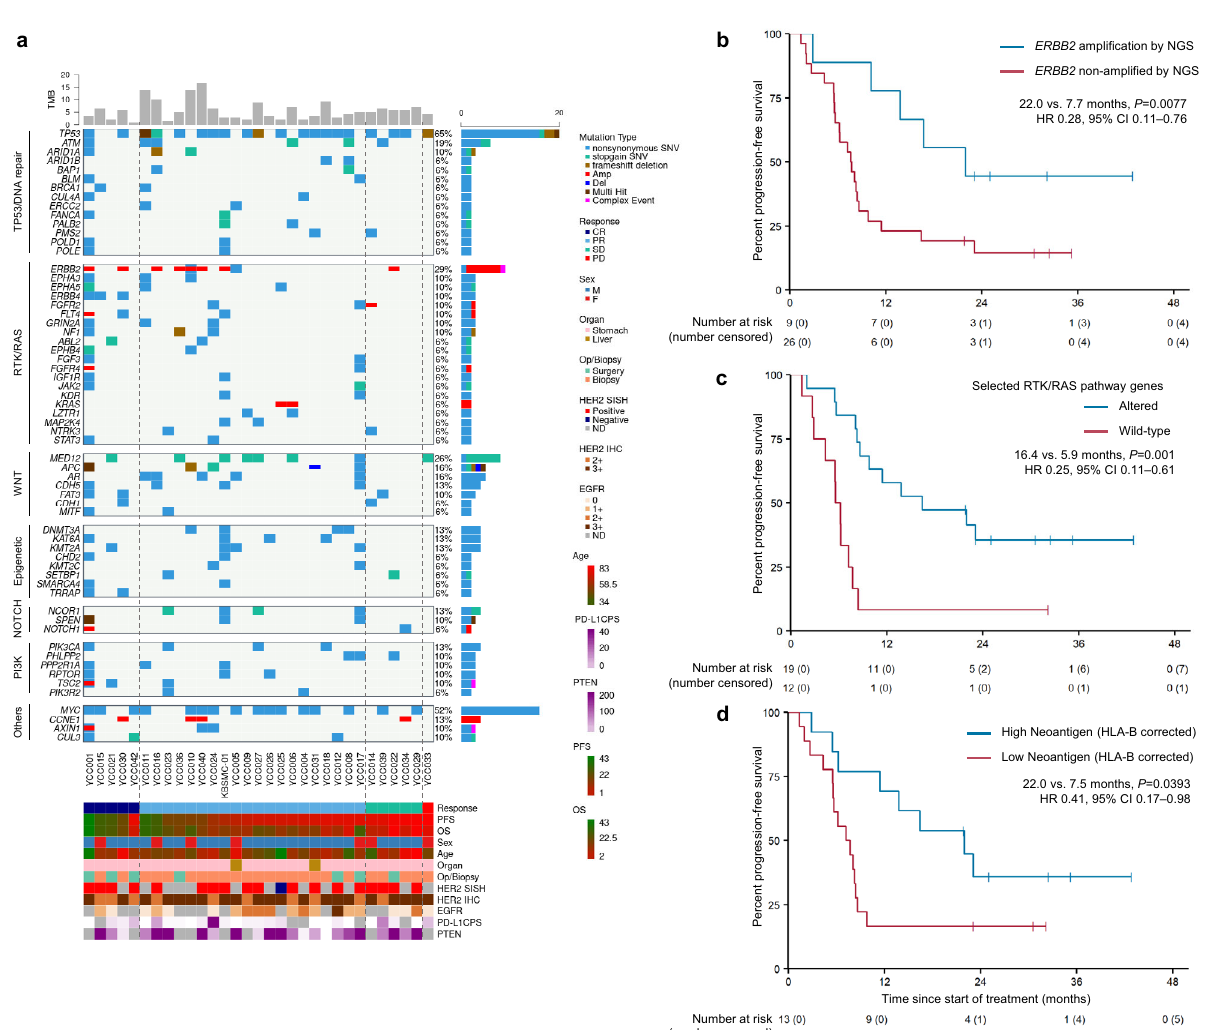
Fig.4|BaselinegenomiclandscapeintheenrolledpatientswithHER2-positive gastric cancer treated with the fi rst-line quadruplet regimen. a Baseline (pre- treatment) tumor tissue-targeted DNA sequencing results grouped by the best response and related clinicopathologic features ( n =31). Curated pathways and selected genes altered in 6% or more of the patients are shown. Other pathways included those related to the cell cycle and the Hippo, MYC, and NRF2 pathways. Vertical dashed lines indicate groups by the best response. b – d Kaplan – Meier survival curves with PFS strati fi ed by pretreatment ERBB2 ampli fi cation as determined via NGS ( b n = 35), RTK-RAS pathway gene